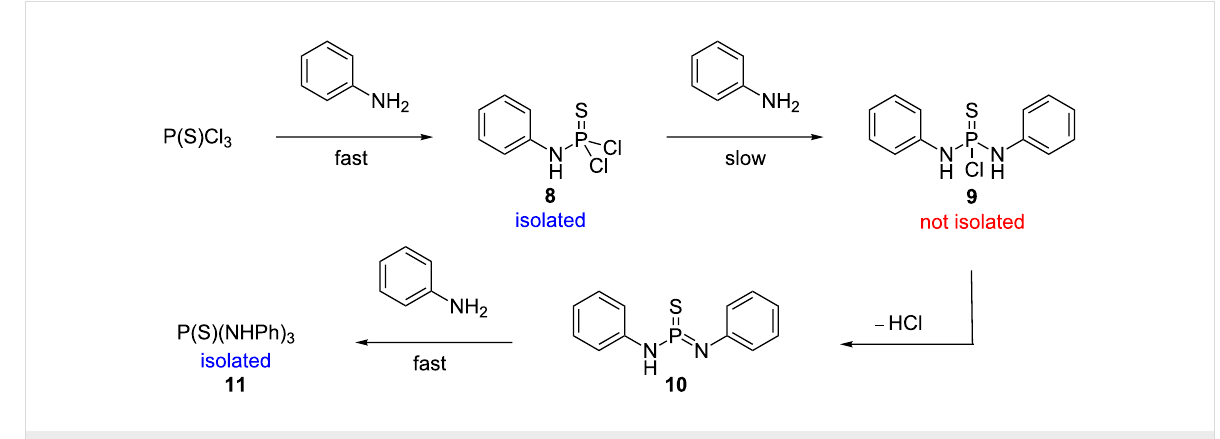
CDCl 3 /DMSO- d 6 at room temperature. Signals that belong to any one proton split into two signals with a ratio of ~5:1/20:1